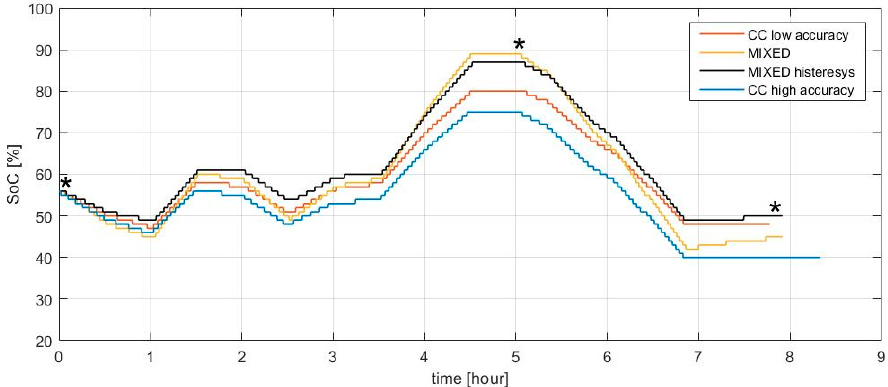
Figure 25. Comparison of the di ff erent SoC estimation methods (* stands for measurement point).